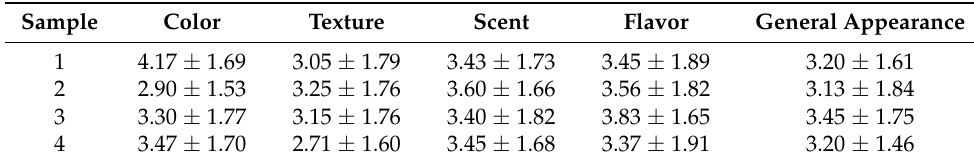
Table 6. Preference test of ´cupter mean ± standard deviation value. Sample Color Texture Scent Flavor General